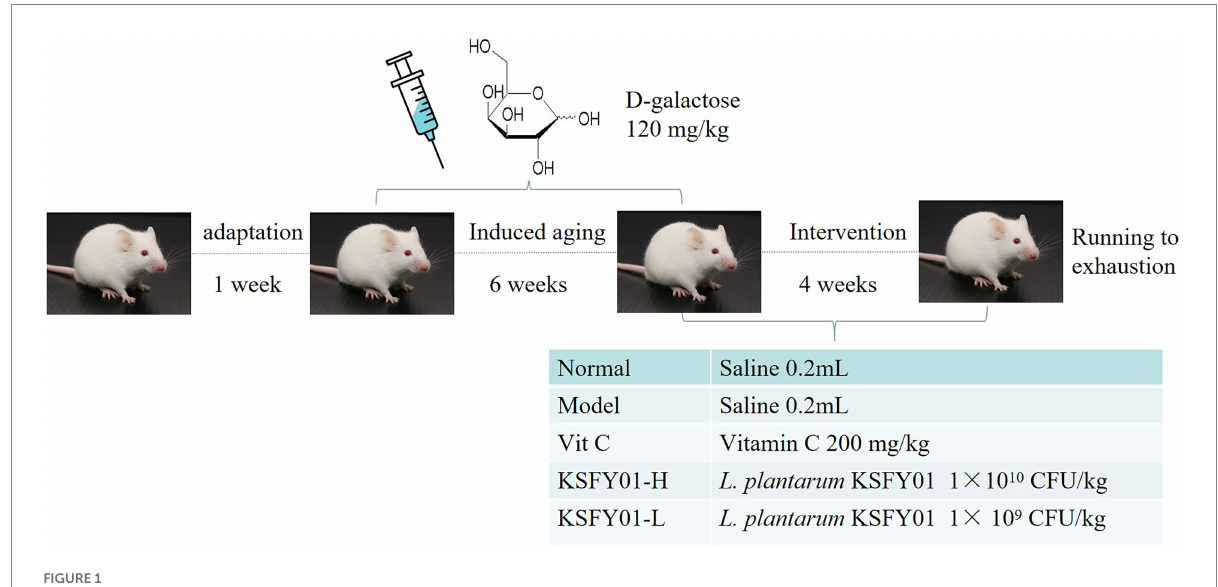
FIGURE 1 Experimental